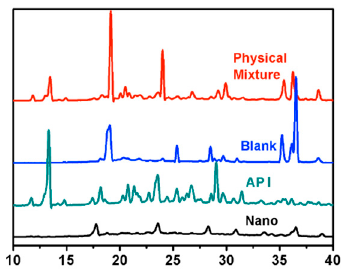
Figure 4. X-ray powder diffraction spectra. Abbreviations: Nano, MDZ nanocrystals; API, MDZ coarse powder.